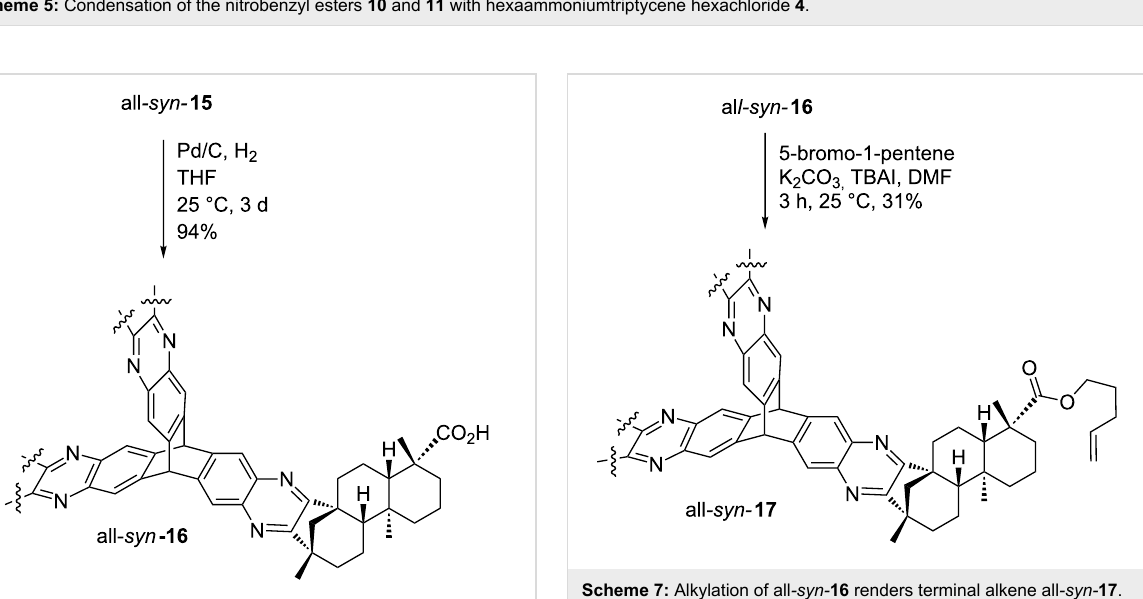
Scheme 5: Condensation of the nitrobenzyl esters 10 and 11 with hexaammoniumtriptycene hexachloride 4 .